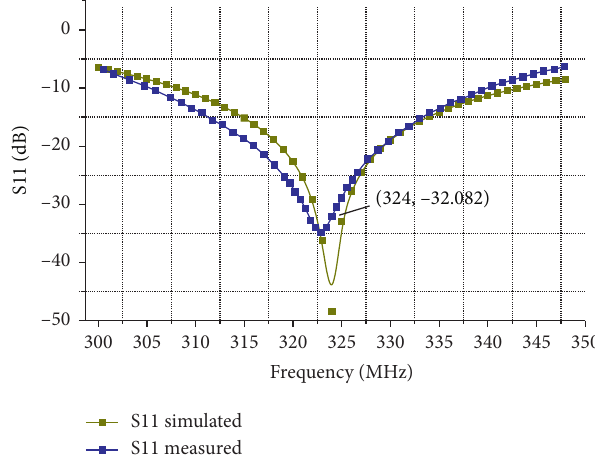
Figure 7: Comparison of measured results and simulation results.